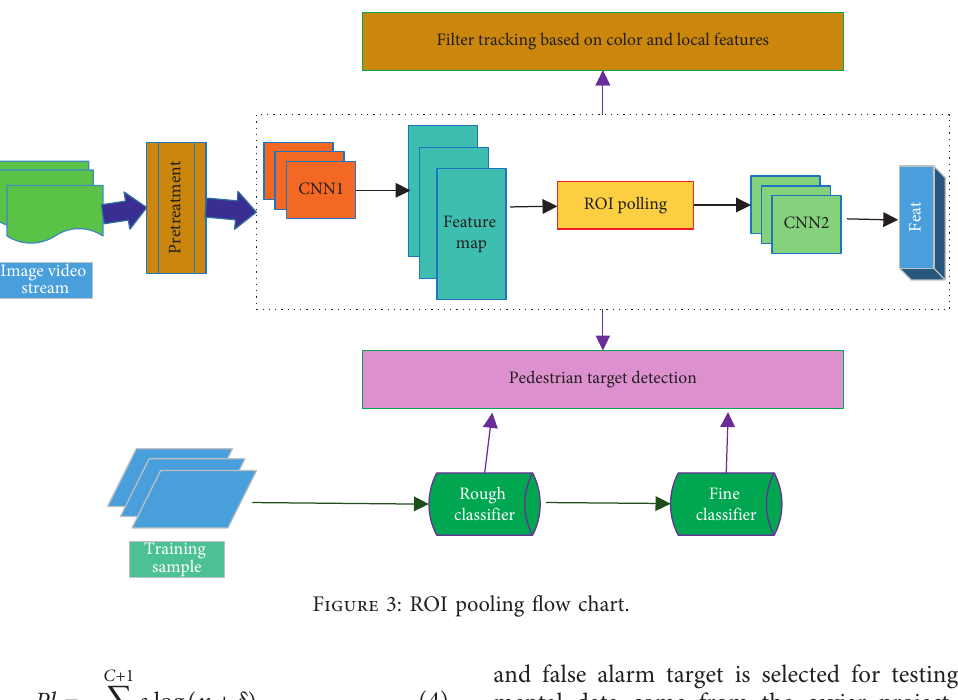
Figure 3: ROI pooling flow